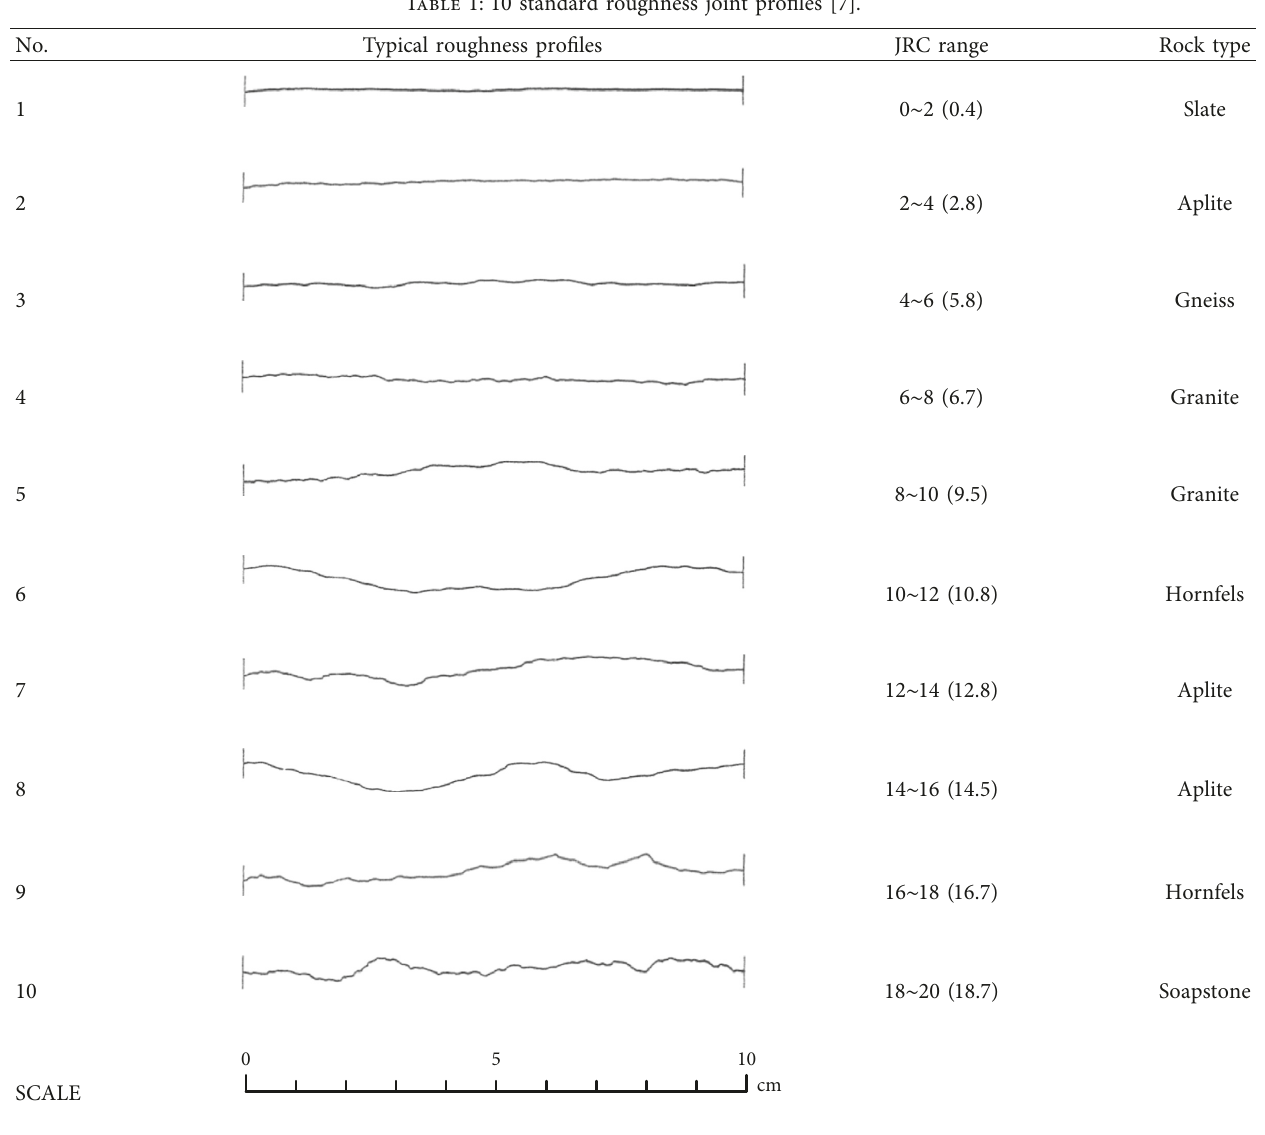
(Table 1) represent the roughness under the condition of FLTR. JRC values of 10 standard profiles under the con- dition of from right to left (FRTL) is unknown. When the above parameters are used to predict the JRC, the estimated shear strengths of rough joints are the same at the shear condition of FLTR and FRTL. Obviously, this situation does not meet the test rules.